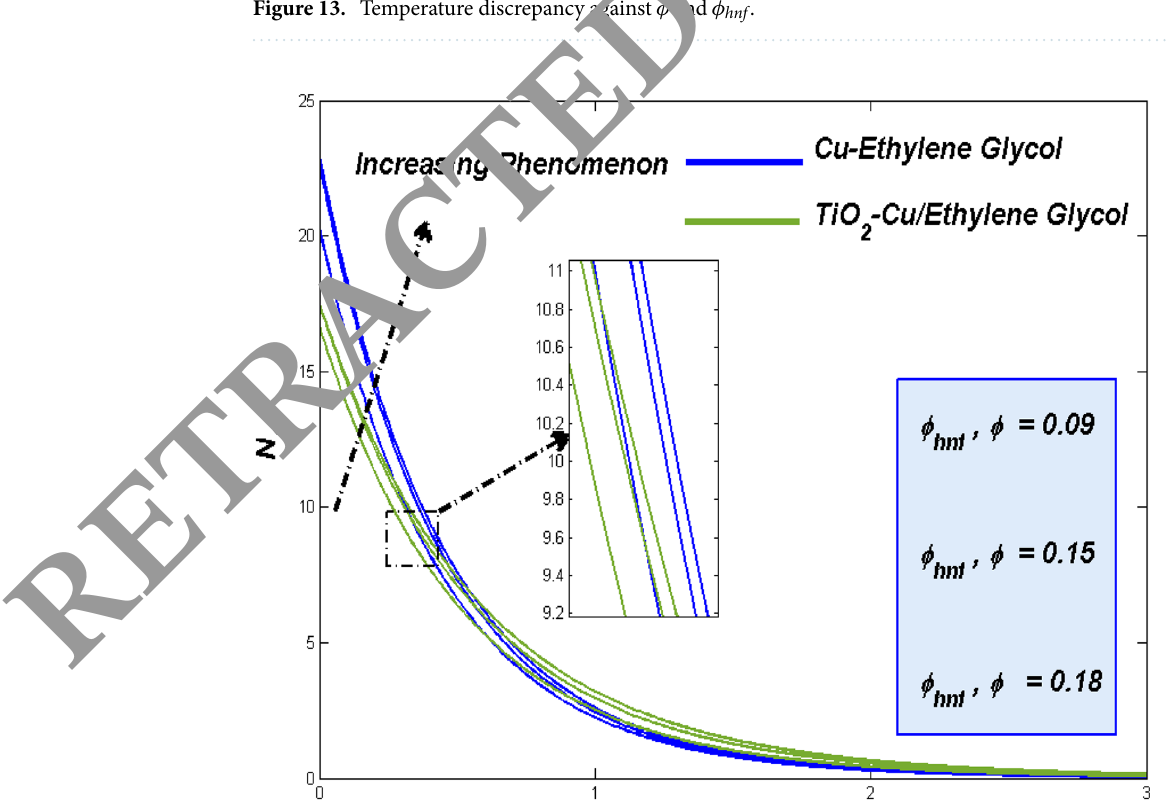
Figure 13. Temperature discrepancy against φ and φ hnf .